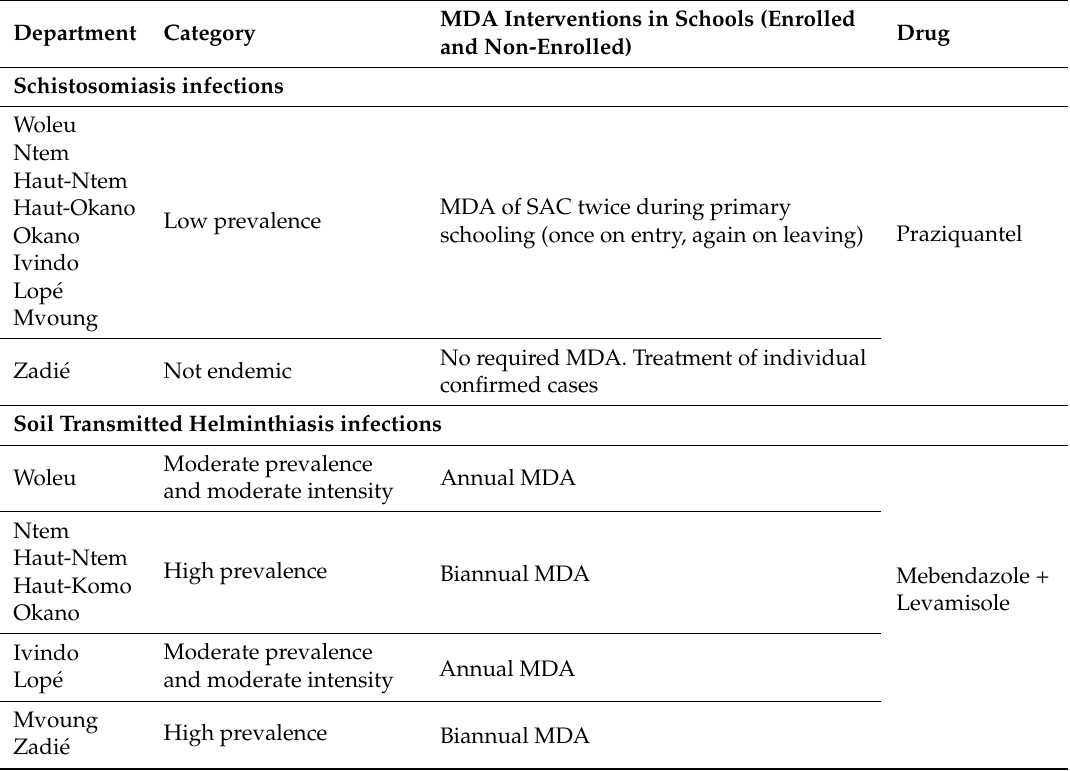
Table 4. Diagnosis of health department and recommended treatment